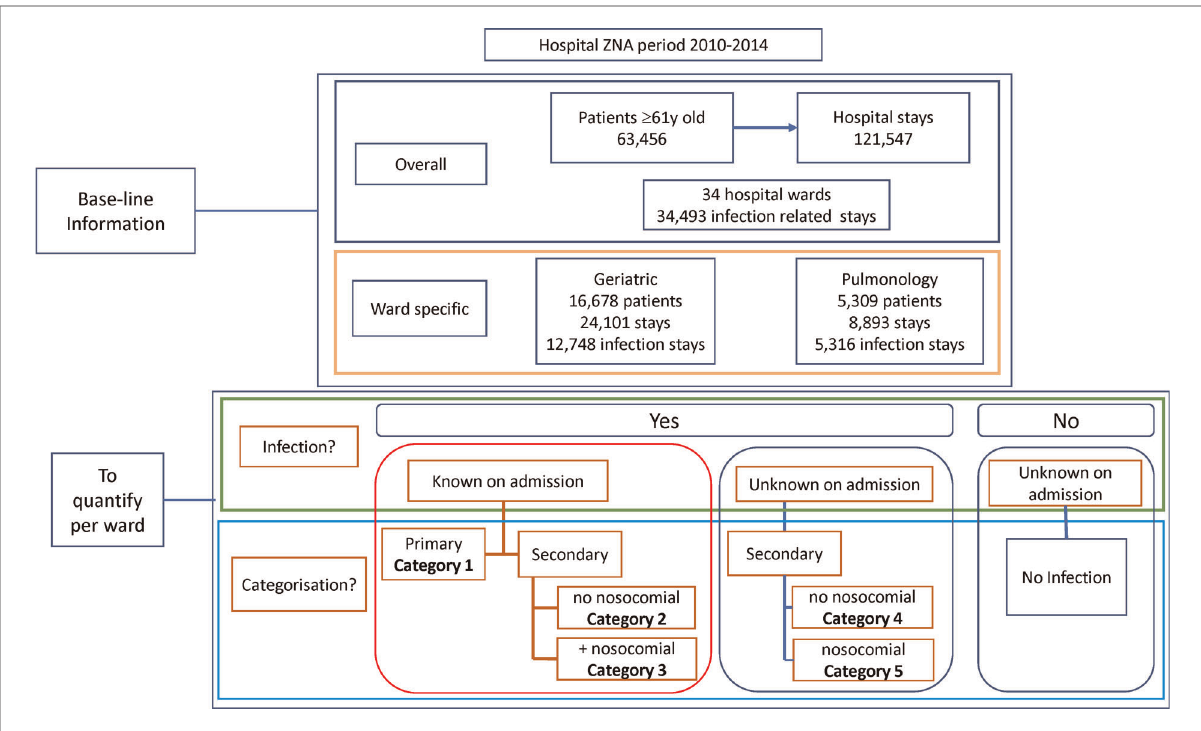
FIGURE 1 Overview of the baseline information obtained at the start of the project about the study population and the objectives of the study